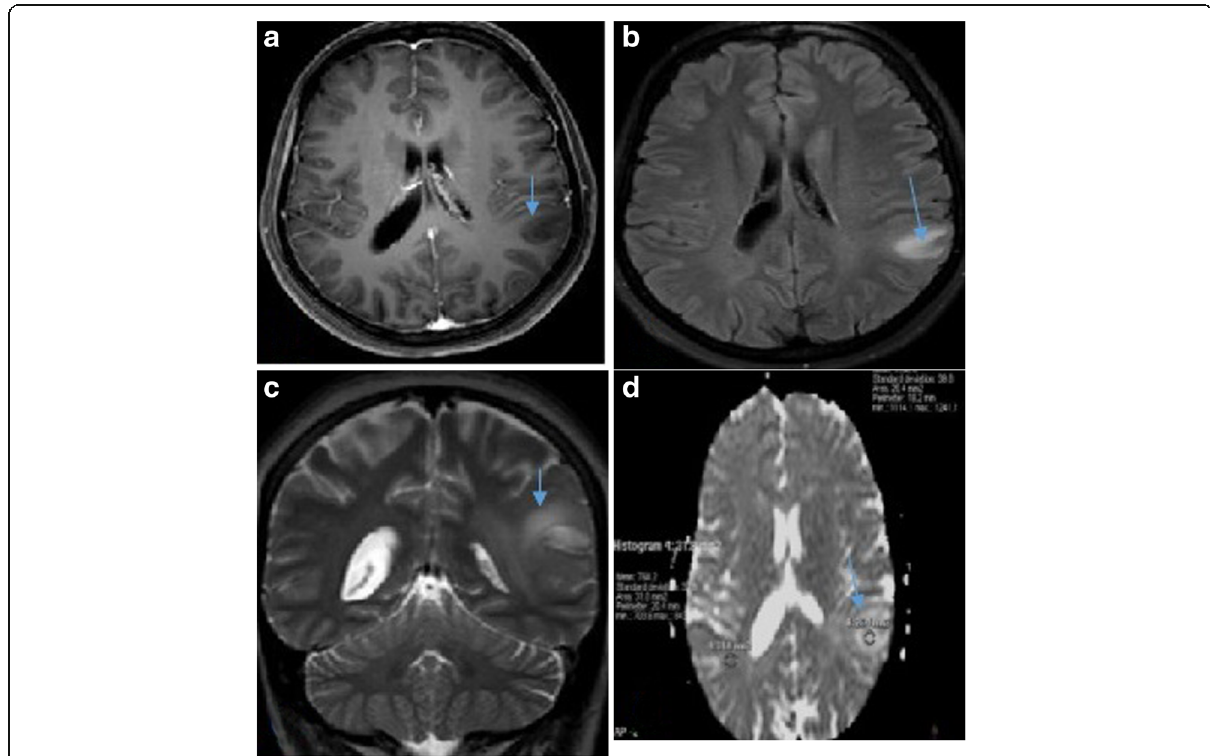
Fig. 3 A 36-year-old female patient with epilepsy. a Cortical thickening in axial T1A sequence. b Subcortical hyperintense in axial FLAIR sequence- blurring in GW matter interface. c Increase in cortical signal intensity in coronal T2A sequence-blurring in GW matter interface. d Hyperintense area in axial dADC sequence, ADC measurement from this area and from a symmetrical